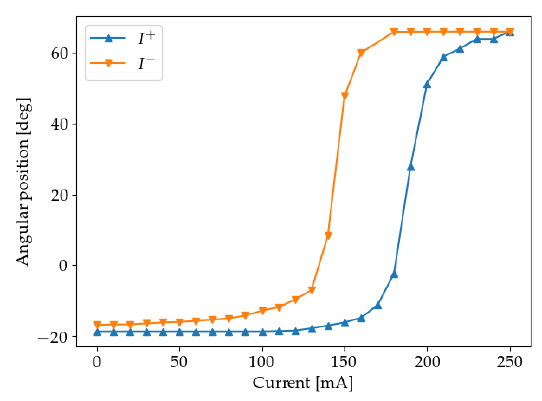
Figure 10. Characterization of the system. I + denotes that the current is monotonically increasing, while I − denotes a monotonical